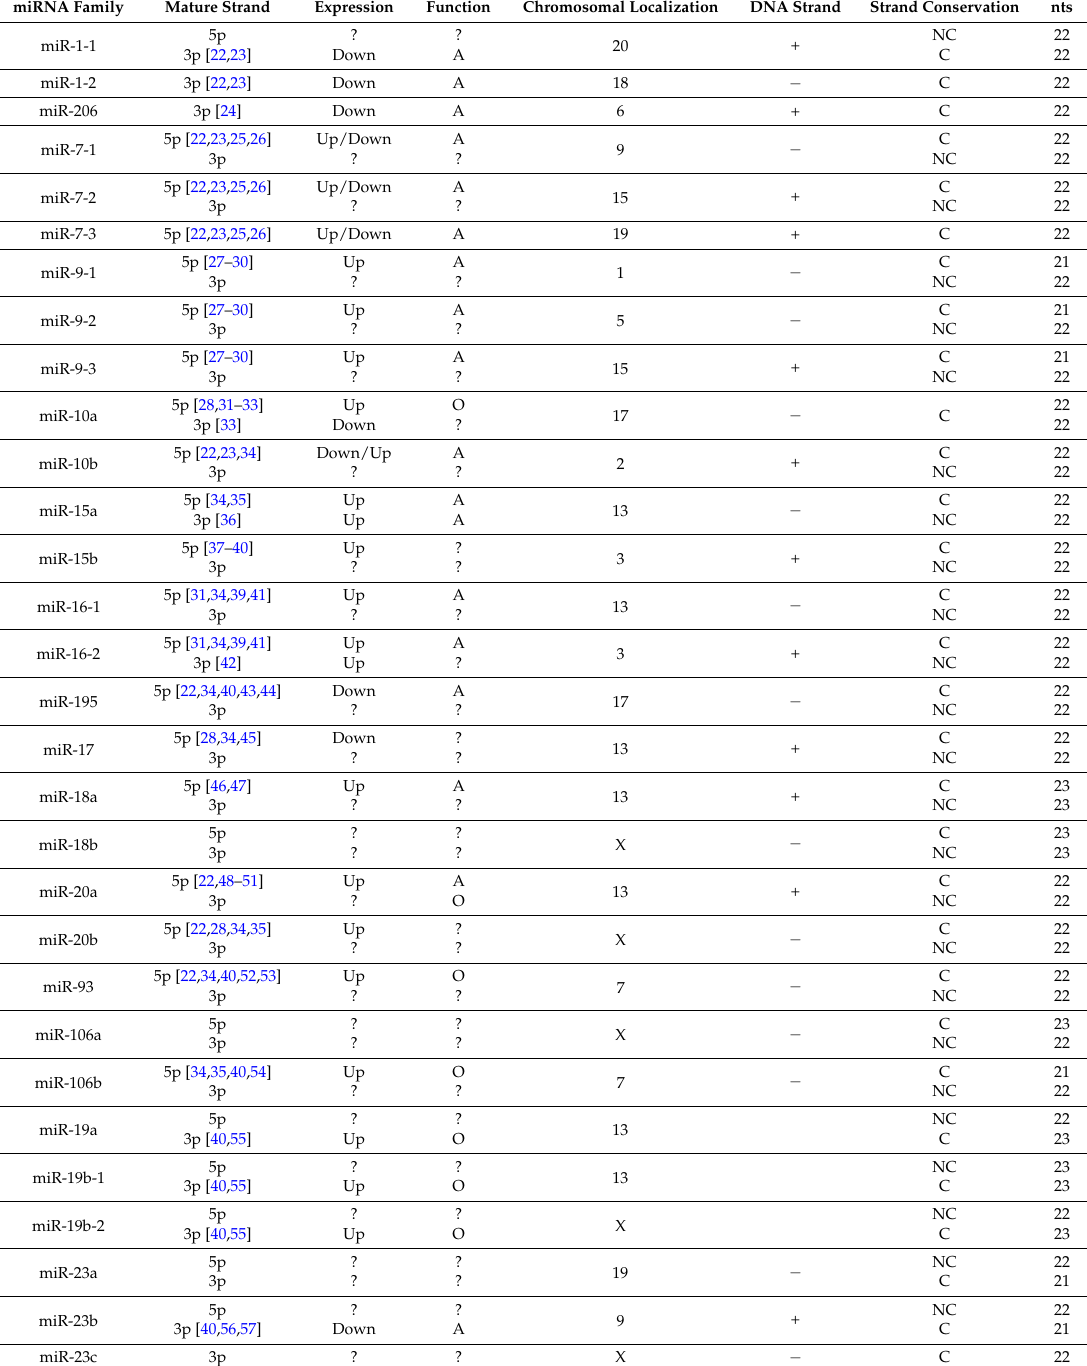
Table 1. miRNAs families showing cervical cancer miRNA expression, function, chromosome localization, DNA strand, mature strand conservation, and nt chain sizes. ? = unknown, + DNA strand = strand direction from 5 (cid:48) to 3 (cid:48) , − DNA strand= strand direction from 3 (cid:48) to 5 (cid:48) , C = Conserved strand, NC = Not conserved strand, A = Anti-oncomiR, O = OncomiR, nts = nucleotides. miRNA Family Mature Strand Expression Function Chromosomal Localization DNA Strand Strand Conservation nts